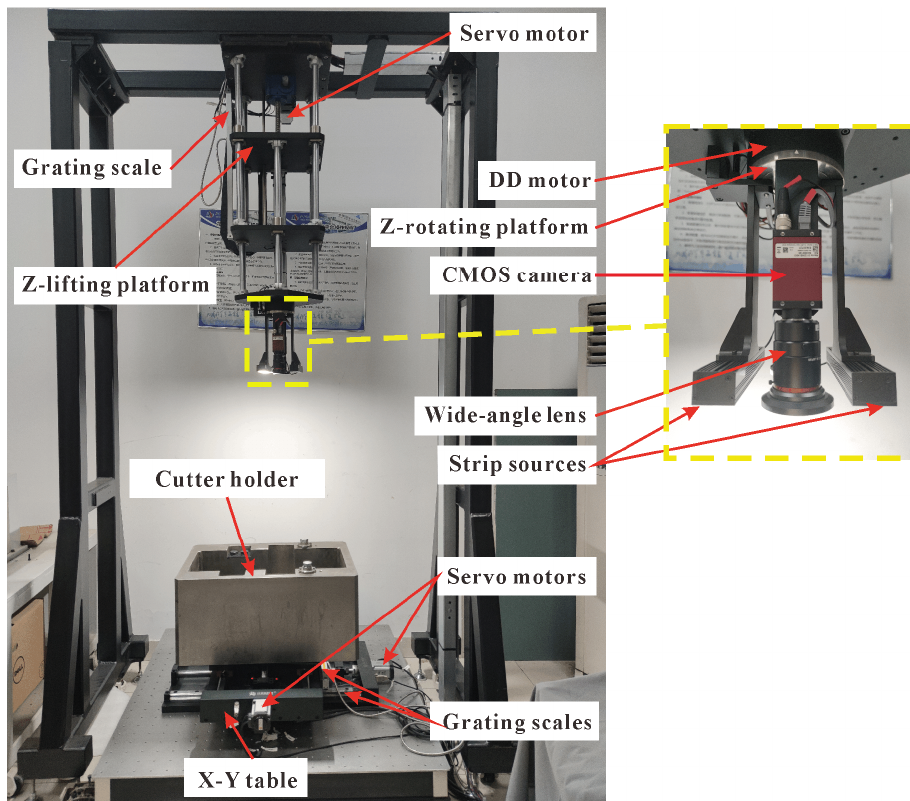
Figure 7. Visual system and four-axis motion platform.